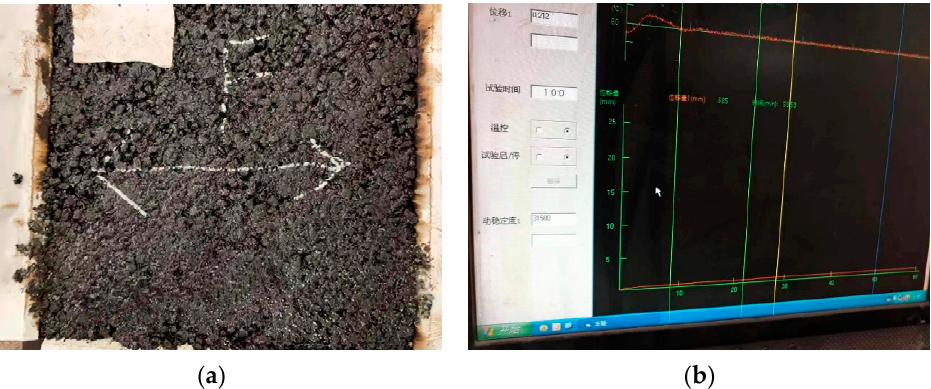
Figure 11. Road surface sliding resistance test: ( a ) test direction; ( b ) total rutting slab deformation.